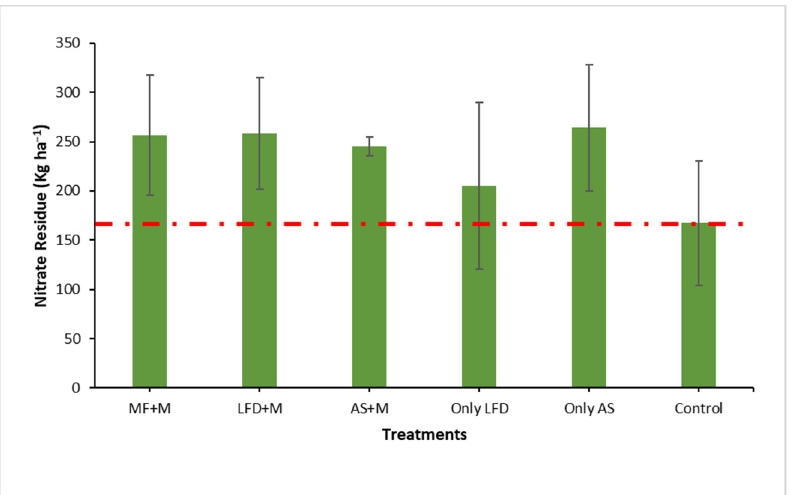
Figure 7. Amount of nitrate residue (kg ha − 1 in 0–90 cm soil depth) in post-harvest period for five treatments (MF + M = CAN + manure, LFD + M = liquid fraction of digestate and manure, AS + M = ammonium sulphate solution and manure, only LFD = standalone treatment from liquid fraction of digestate, and only AS = standalone treatment from ammonium sulphate solution). Red dotted line represents the legislative limit (165 kg ha − 1 ) according to Flemish environmental standards.